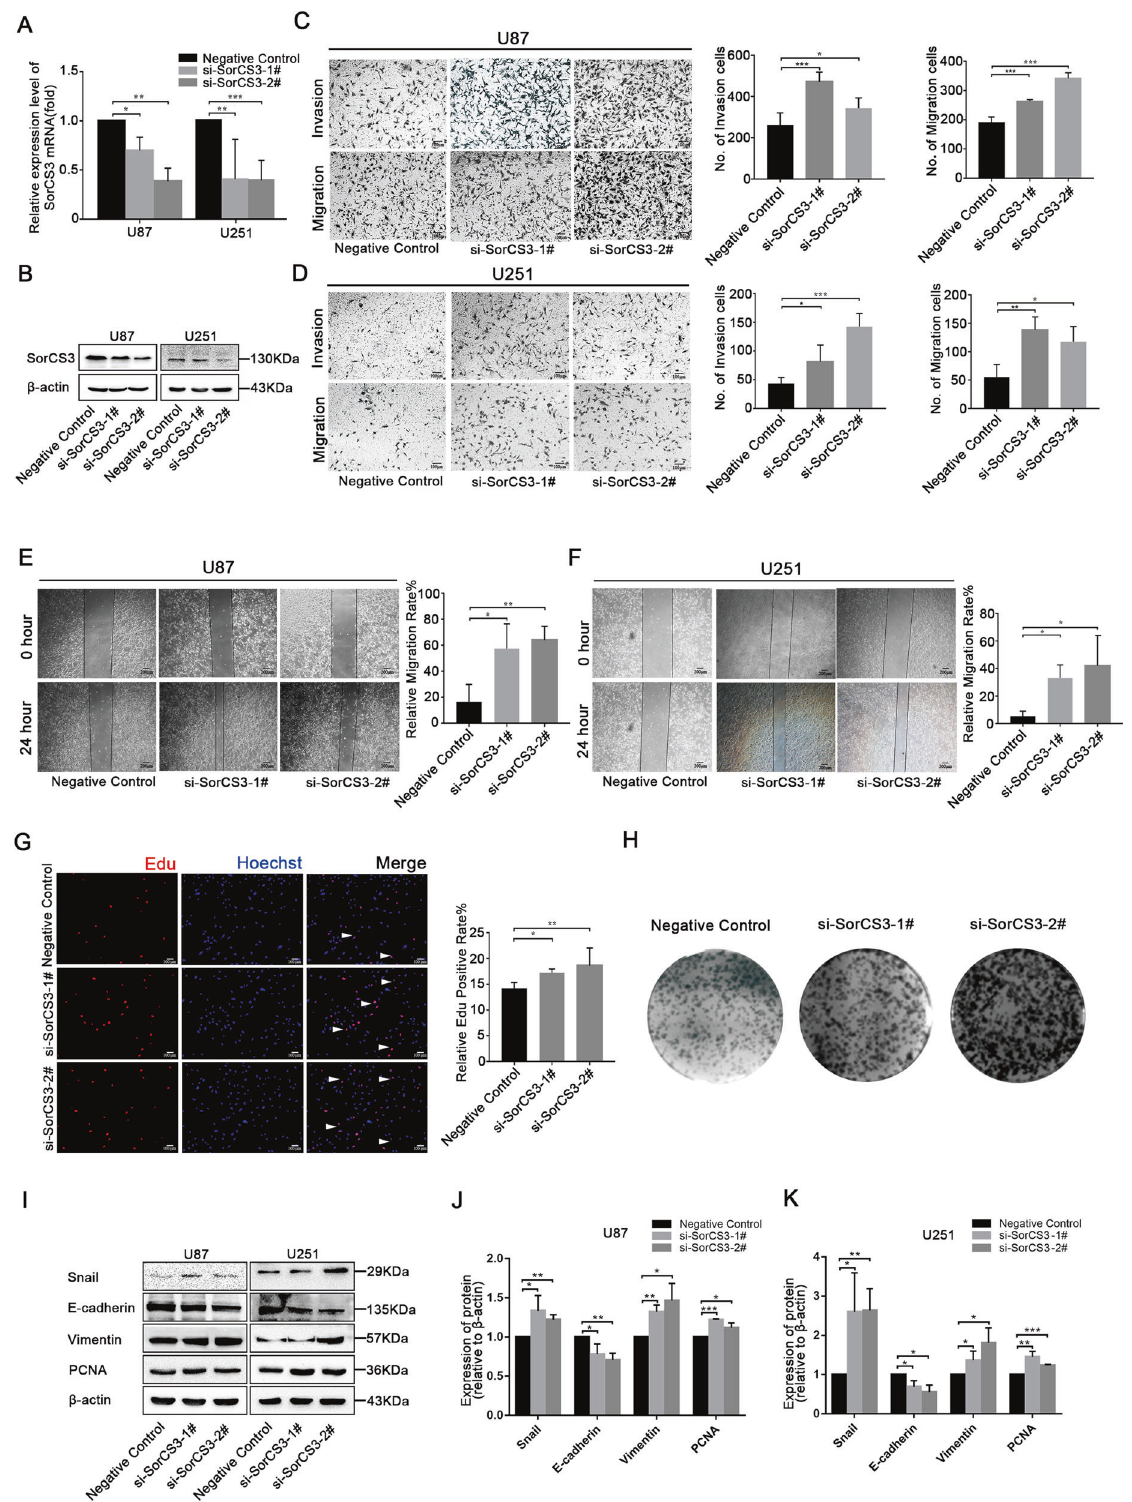
Fig. 3 Knockdown of SorCS3 promotes the proliferation, migration and invasion of glioma cells in vitro. A , B After siRNA-SorCS3-1# and 2# transfection, the expression levels of SorCS3 were examined through real-time PCR and western blotting, using β -actin as an endogenous control. C , D Transwell assays used to determine the in fl uence of transfection with si-SorCS3-1# and 2# on the migratory and invasive abilities of U87 and U251 cells. E , F Effect of SorCS3 knockdown on wound healing of U87 and U251 cells. G Cell proliferation was determined by EdU staining in SorCS3 knockdown condition and EdU incorporation was calculated as EdU + cells/total cells, quanti fi ed by ImageJ. Red was stained for proliferation (EdU + ), blue was stained for nucleus. H Colony formation assay for assessing the cell proliferation of knockdown SorCS3. I – K Western blot analysis of proliferation- and EMT-associated marker after transfection with SorCS3 siRNA. Data are shown as mean ± S.D. including three independent experiments. * p < 0.05; ** p < 0.01; *** p < 0.001. Cell Death and Disease (2022)